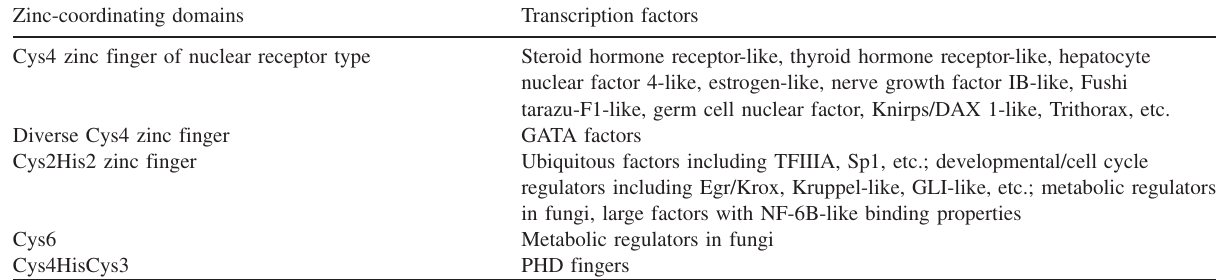
Table 2 Transcription factors with zinc-coordinating domains.